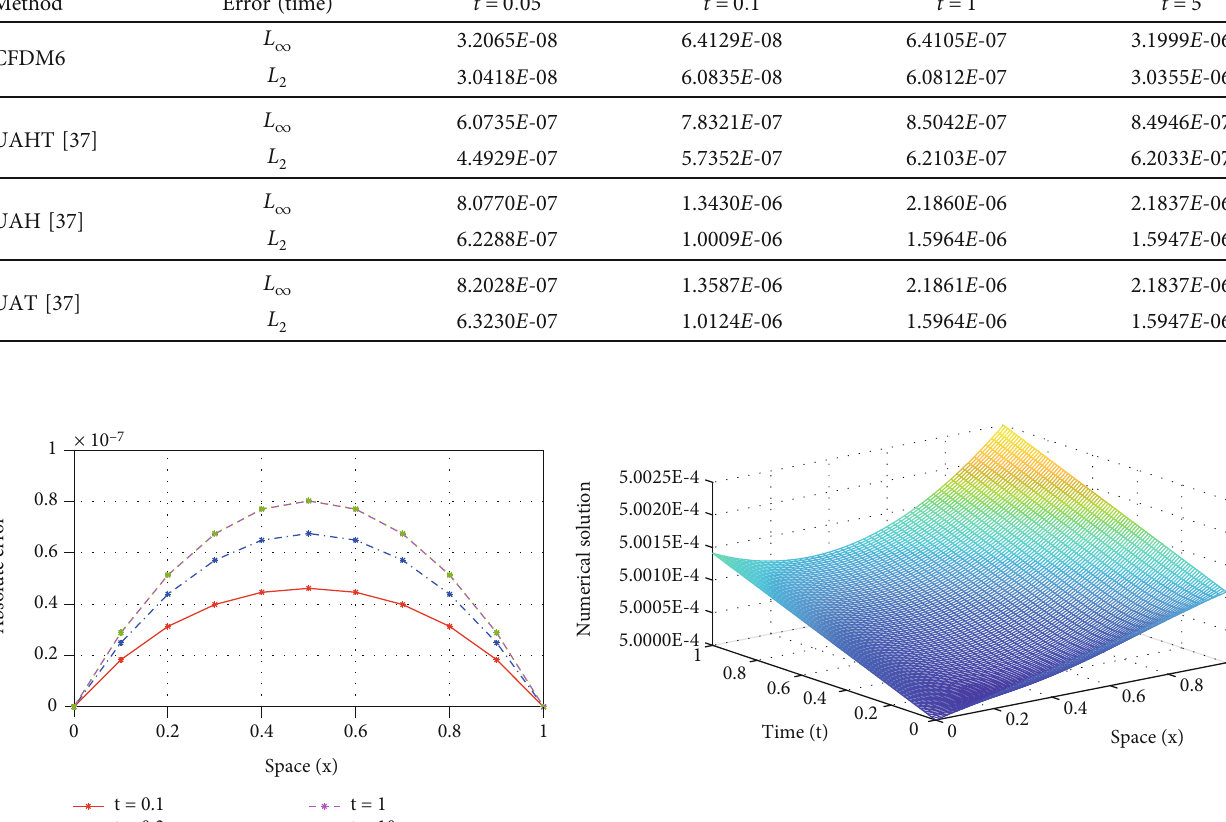
Table 6: Comparison of error norms of Example 4 with β = 1 , γ = 1 , η = 0 : 001 , δ = 2 , h = 0 : 1 , and Δ t = 0 : 01 . Method